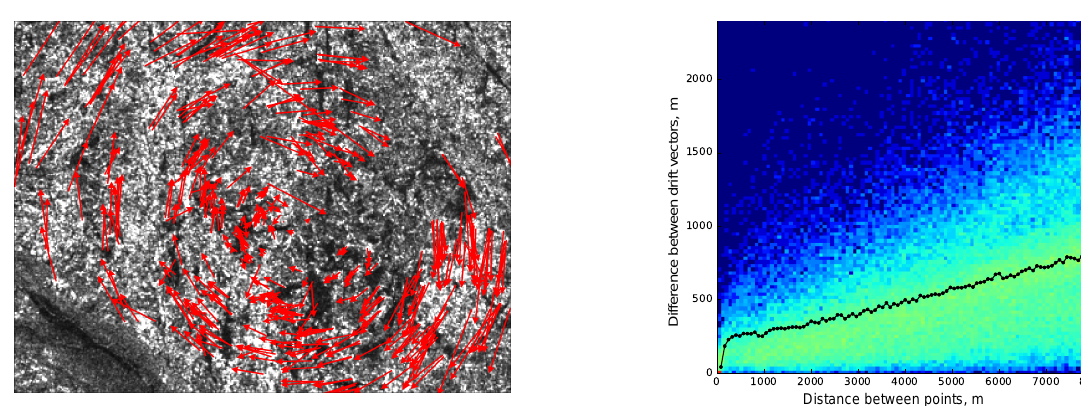
Figure 12. Variogram of drift vectors (black line) on top of 2-D his- togram of distance between vectors and difference between vectors estimated from vectors identified on the Sentinel-1 image pair Fram Strait (Table 1). Colour of the 2-D histogram indicates the number of